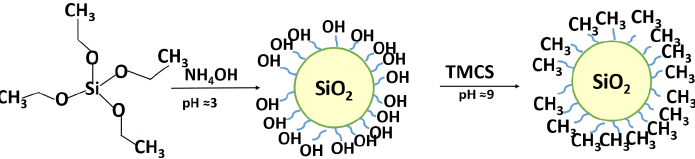
Figure 2. Process of formation of superhydrophobic SiO 2 /TMCS coating.